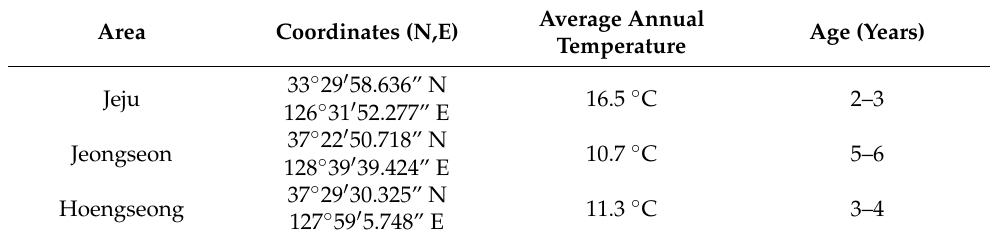
Table 1. Basic and geographic information of C. lanceolata samples used in this